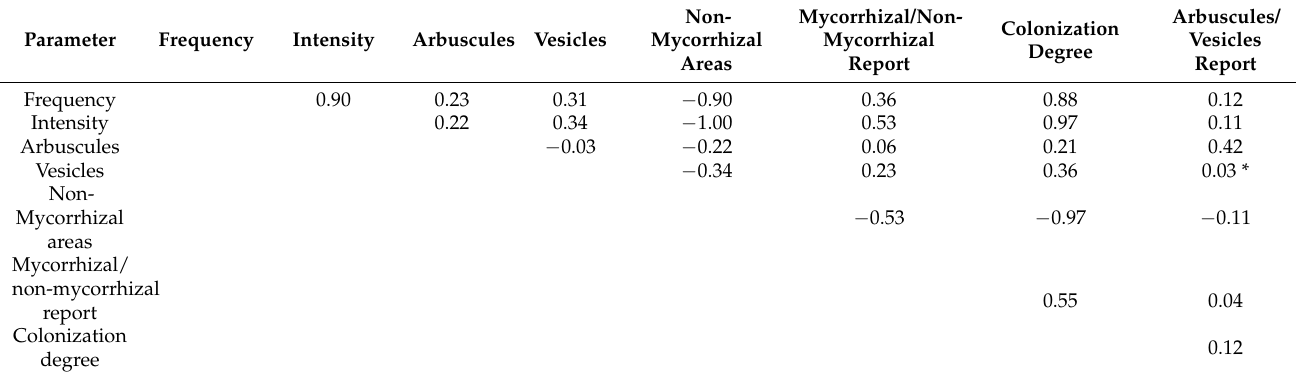
Table 2. General Pearson correlation between colonization